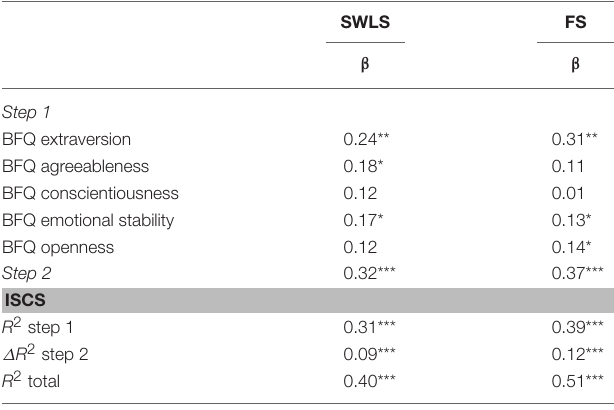
TABLE 2 | Hierarchical